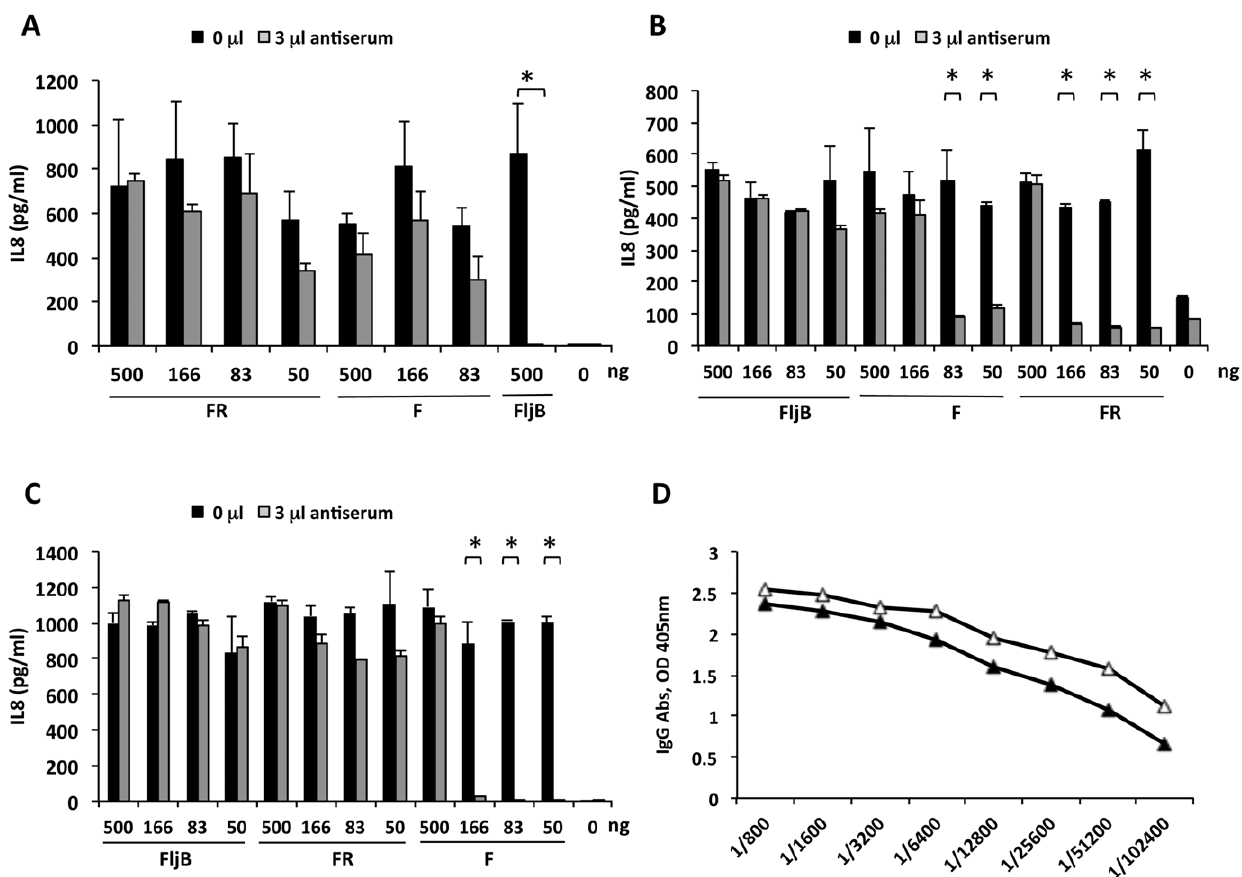
Figure 5. Antibody mediated cross-neutralization of MA and STF flagellins measured by the IL8 secretion by Caco-2 cells. Caco-2 cells were incubated with a premix of 3 m l (grey bars) or 0 m l (black bars) of anti-flagellin hyperimmune serum with MA or STF flagellins. The flagellins (abscissa) indicated were pre-incubated with anti-FljB antiserum (A), anti-FR antiserum (B), and anti-F antiserum (C). (D) Panel showing the IgG titration profile of anti-FljB ( n ) and anti-FR ( m ).*, statistical significance differences at the p # 0.05 level.